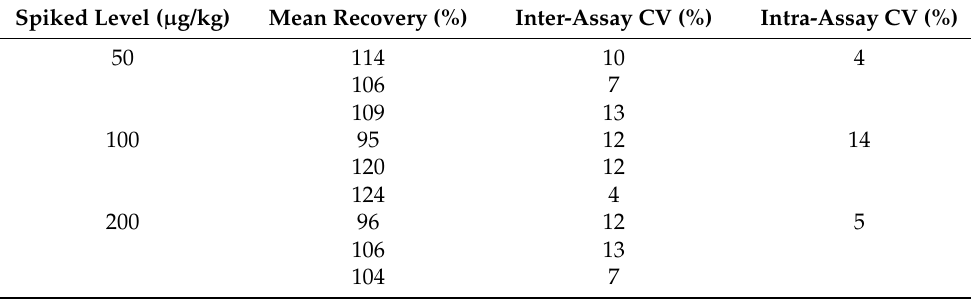
Table 3. The recoveries of the ic-ELISA for the determination of DAS in rice. Spiked Level ( µ